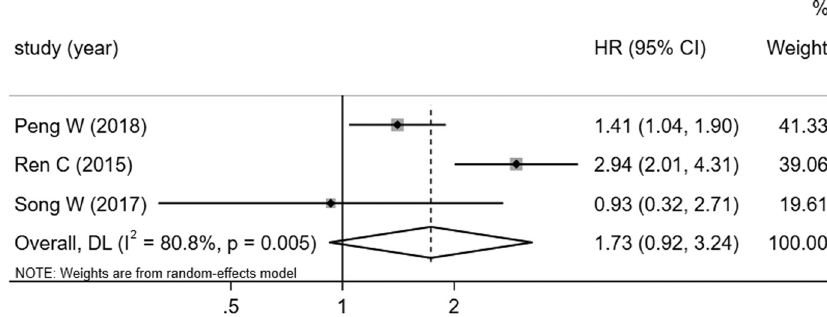
Figure 5: Forest plots of the studies that evaluated the HRs of high miR - 92a expression on univariate